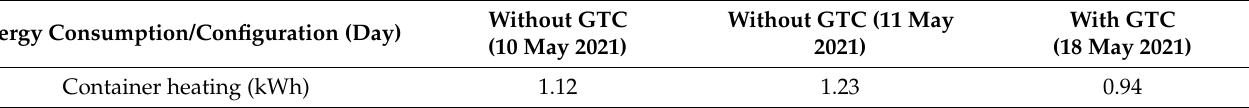
Table 8. Heating energy consumption: experimental building without/with GTC.